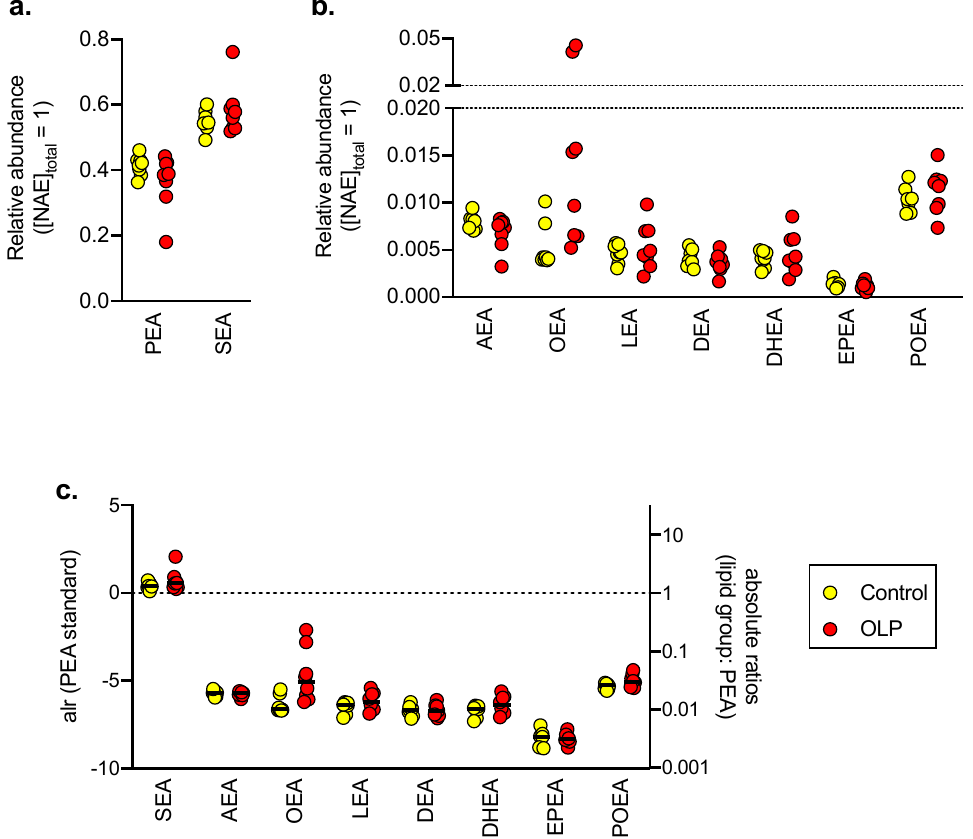
Figure 3. Composition of NAEs in control and OLP tissue biopsies. In panels ( a , b ), fractional contents, i.e., the concentration of lipid / combined concentration of all nine NAEs are shown for each case. Note the different scales on the y axis in the panels. In panel ( c ), the data are expressed as the additive log ratio (alr), with PEA as the denominator, i.e., ln(lipid/[PEA]), with the anti-logged absolute ratios shown on the right y axis. The solid horizontal bars represent the means. Abbreviations (when not already explained): LEA, linoleoyl ethanolamide; DEA, docosatetraenoyl ethanolamide; DHEA, docosahexaenoyl ethanolamide; EPEA, eicosapentaenoyl ethanolamide; POEA, palmitoleoylethanolamide.